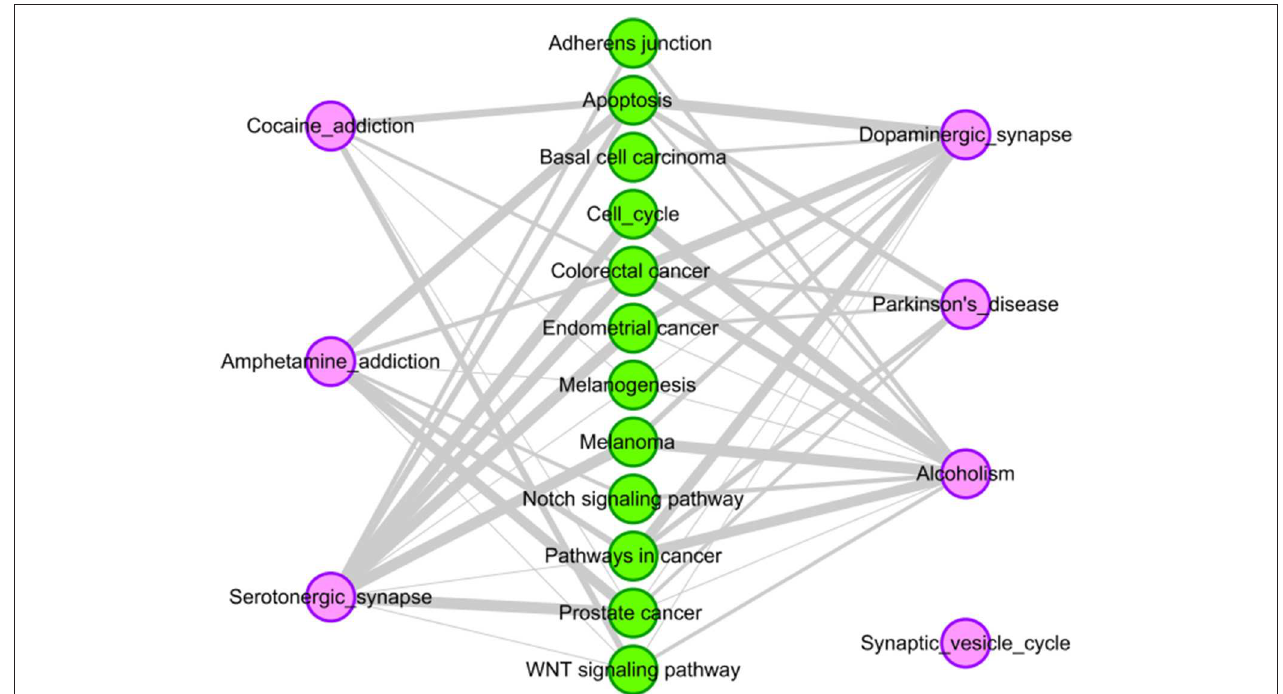
FIGURE 5 | Pathway analysis of reserpine. The purple circles represent pathways of reserpine, and the green circles represent the tissue-specific KEGG pathways of HCC. The gray edges indicate that there are common genes between two pathways, and the more genes there are, the wider the edges in the network.